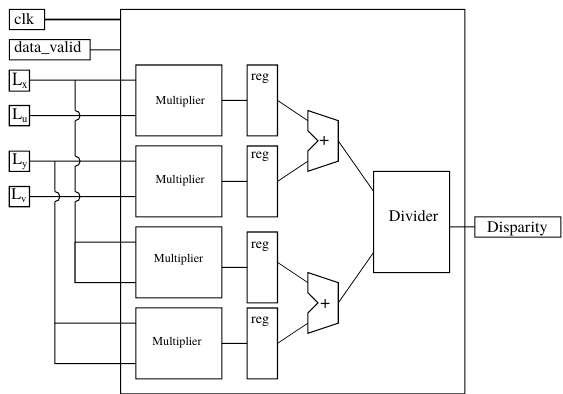
Figure 10. Block diagram of disparity estimation